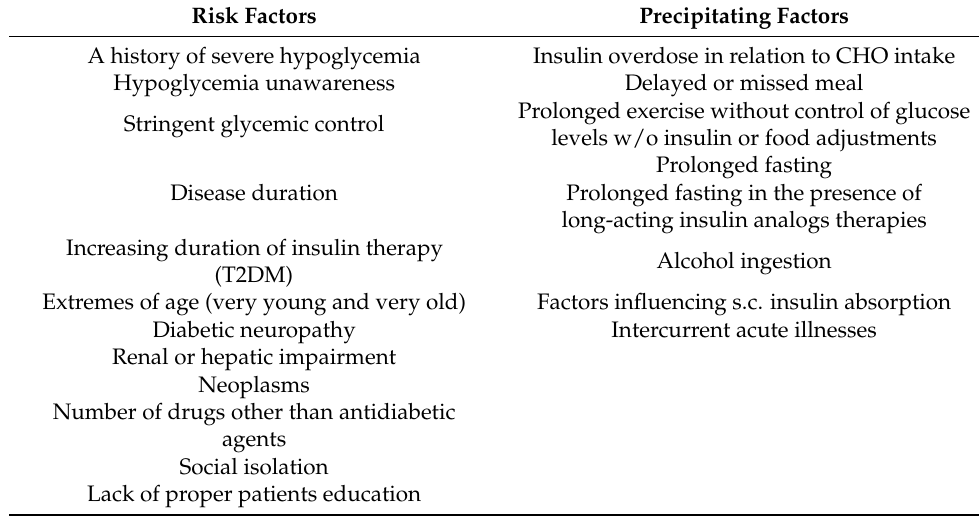
Table 1. Risk and precipitating factors for hypoglycemia.